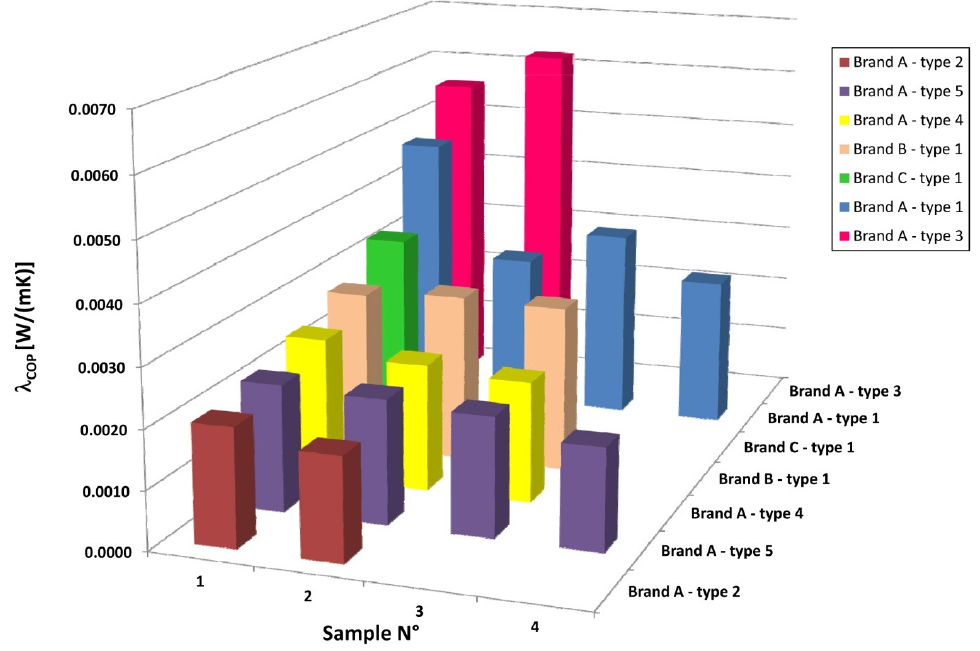
Figure 2. Measured values of the λ COP for various